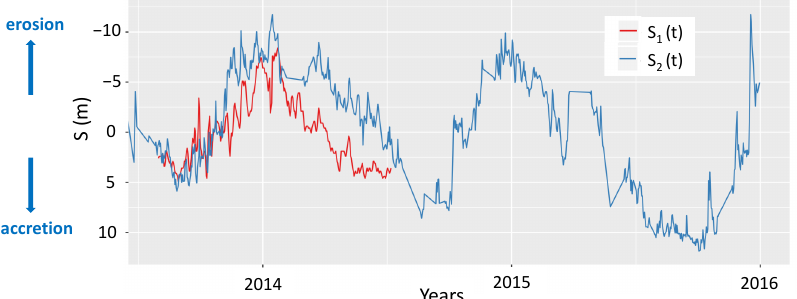
Figure 4. Time series of shoreline position S 1 ( t ) from DS 1 (red line) and S 2 ( t ) from DS 2 (blue